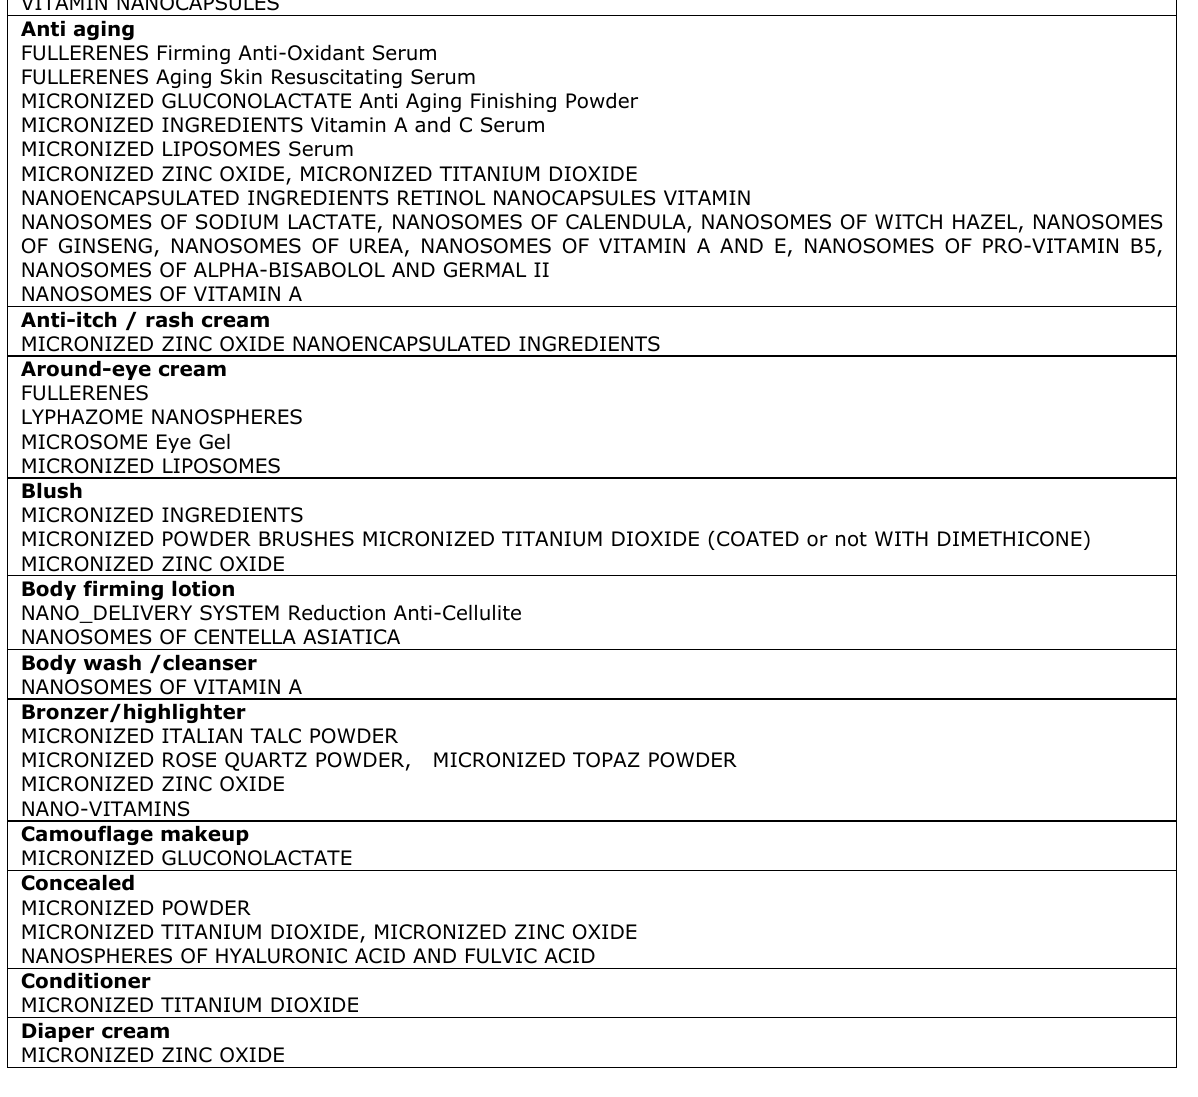
Table 2. Examples of nanocosmetic products in the market After sun products VITAMIN NANOCAPSULES Anti aging FULLERENES Firming Anti-Oxidant